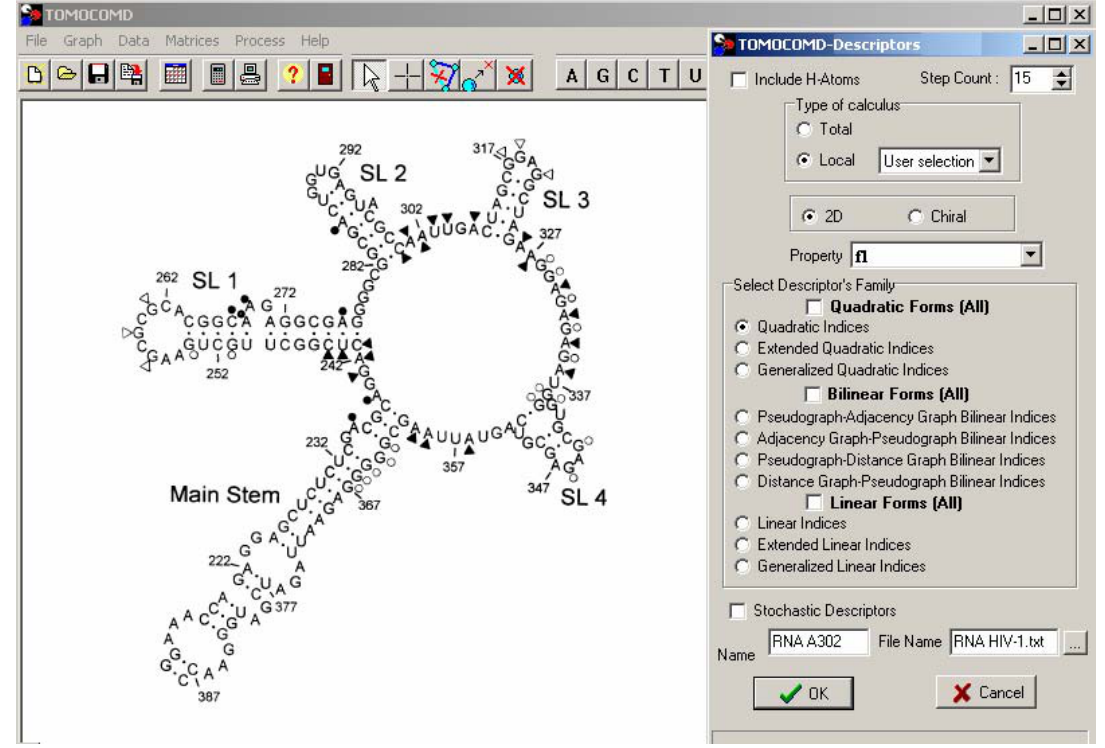
Figure 1. HIV-1 Ψ -RNA packaging region represented on the TOMOCOMD-CANAR interface. Nucleotides involved in binding and enhancement (structural changes) for RNAse I are shown as filled circles and triangles, respectively (open symbols indicates the use of RNAse